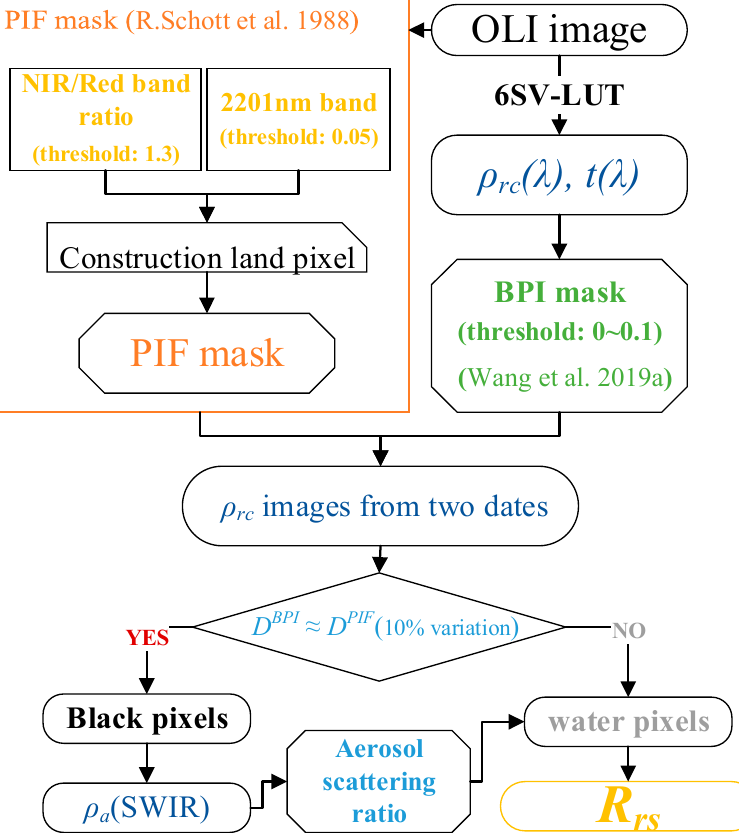
Figure 4. Processing procedure of the m-ACZI algorithm. Note: These thresholds are for Lake Taihu and may need to be adjusted for other waters [12,17].